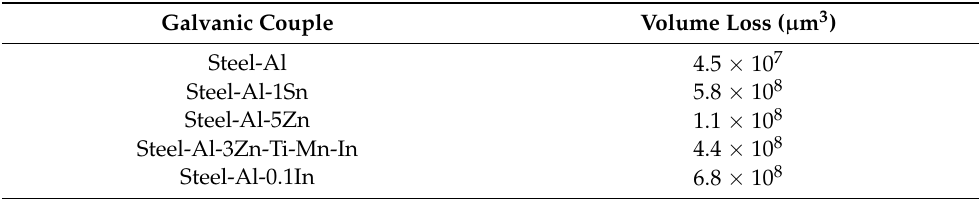
Table 6. Volume-loss calculation of selected confocal laser scanning images after corrosion product